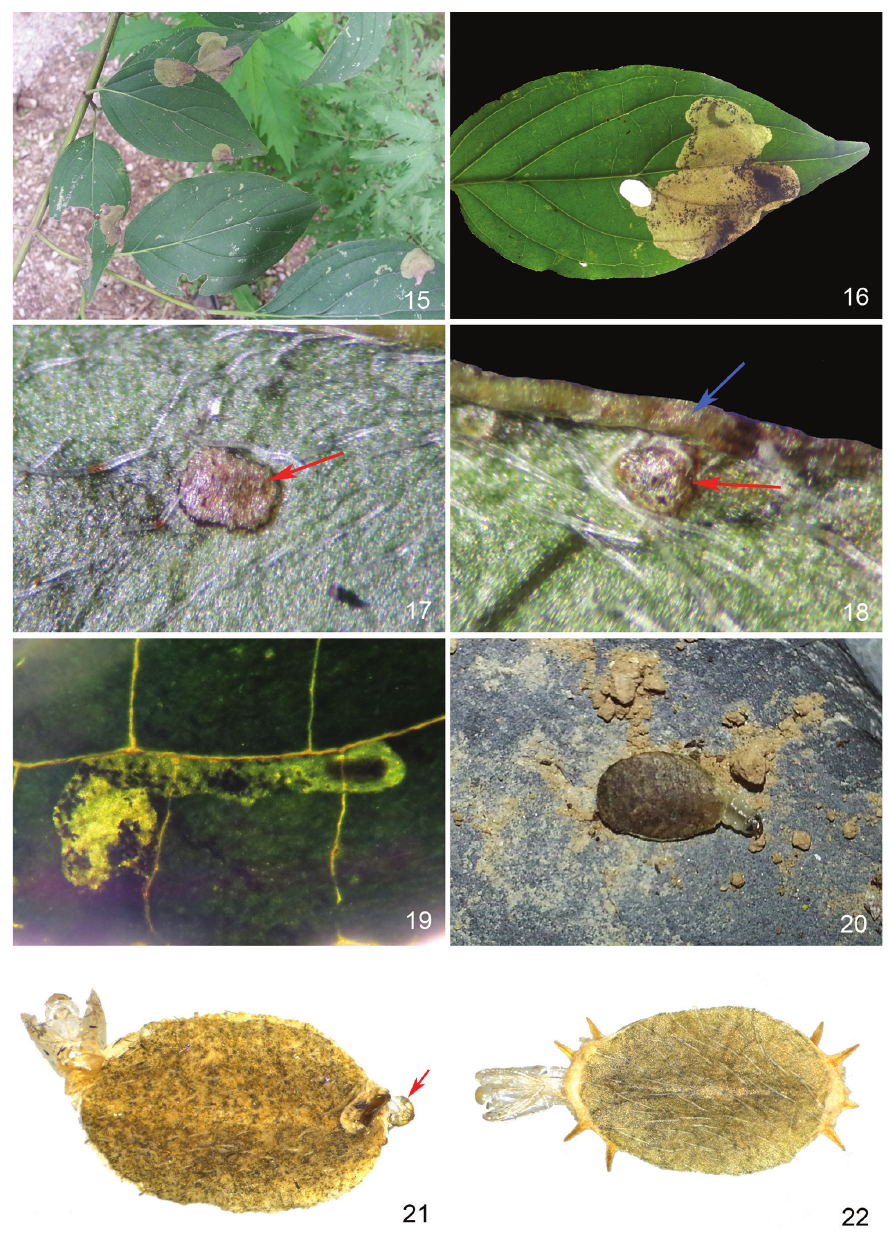
Figures 15–22. Leaf mine, host plant and shield of Antispila sinensis sp. n. 15 Leaf mines on Cornus walteri 16 A large blotch mine occupied by two larvae one of which has made a cut-out 17 piercing scar on the disc of a leaf indicated by a red arrow 18 piercing scar (red arrow) near margin of a leaf where callus also occurs (blue arrow) 19 Early linear mine with an active larva 20 Larva in freshly made shield, search- ing for a pupation site on the ground 21 Shield without spines along margin, pupal exuviae and exuviae of prepupa (red arrow) 22 Shield with several spines along margin, pupal